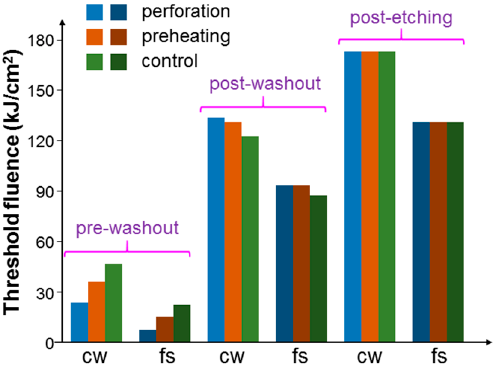
Figure 8. Threshold fluences with the illuminations of the focused 1064-nm cw and fs lasers under the pre-washout, post-washout, and post-etching conditions when cells were incubated with NRI only.